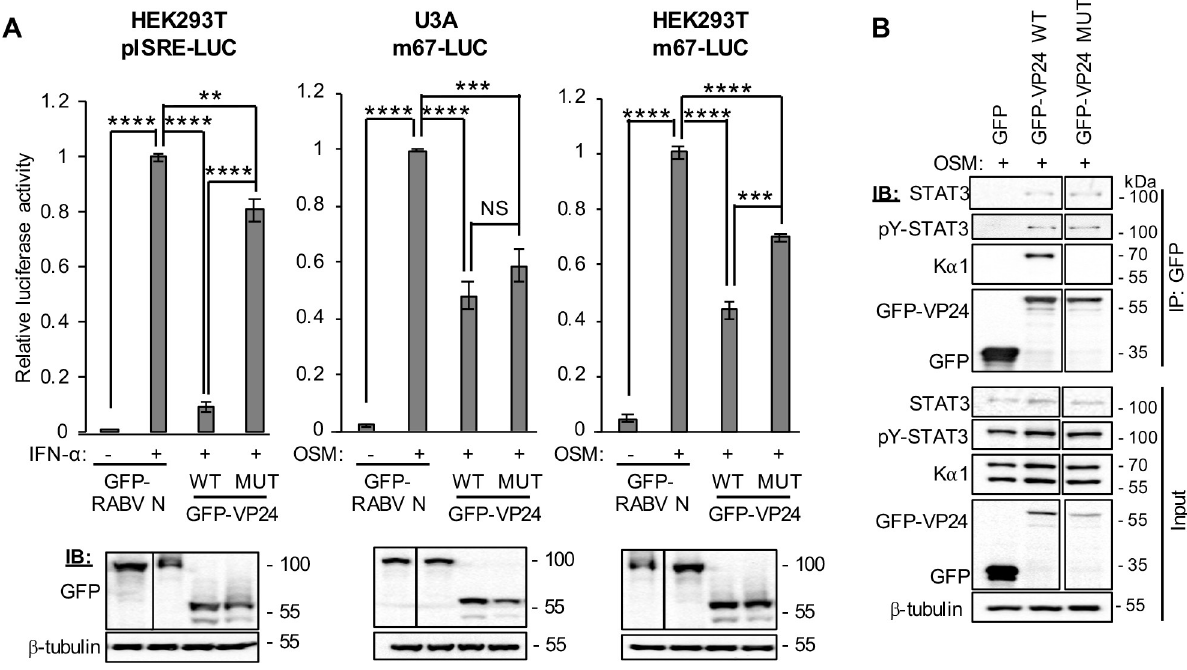
Fig 8. Antagonism of STAT3 by EBOV VP24 in U3A cells is independent of VP24-karyopherin interaction. (A) upper panel : HEK293T or U3A cells co-transfected with pISRE-LUC or m67-LUC plasmid, pRL-TK plasmid, and plasmids to express the indicated proteins, were treated 8 h (IFN- α ) or 16 h (OSM) post-transfection with or without IFN- α (1,000 U/ml for 16 hours) or OSM (10 ng/ml for 8 h) before determination of relative luciferase activity (mean ± SEM; n � 3 independent assays); lower panel : cell lysates used in representative assays were analysed by IB for GFP and β - tubulin. Statistical analysis used Student’s t -test; �� , p < 0.01; ��� , p < 0.001; ���� , p < 0.0001; NS, not significant. (B) U3A cells transfected to express the indicated proteins were treated with OSM before immunoprecipitation for GFP and IB, as described in the legend to Fig 7. Results are representative of 2 independent assays and show data from a single blot with intervening and marker lanes removed. Expanded images of membranes are shown in S11 Fig.